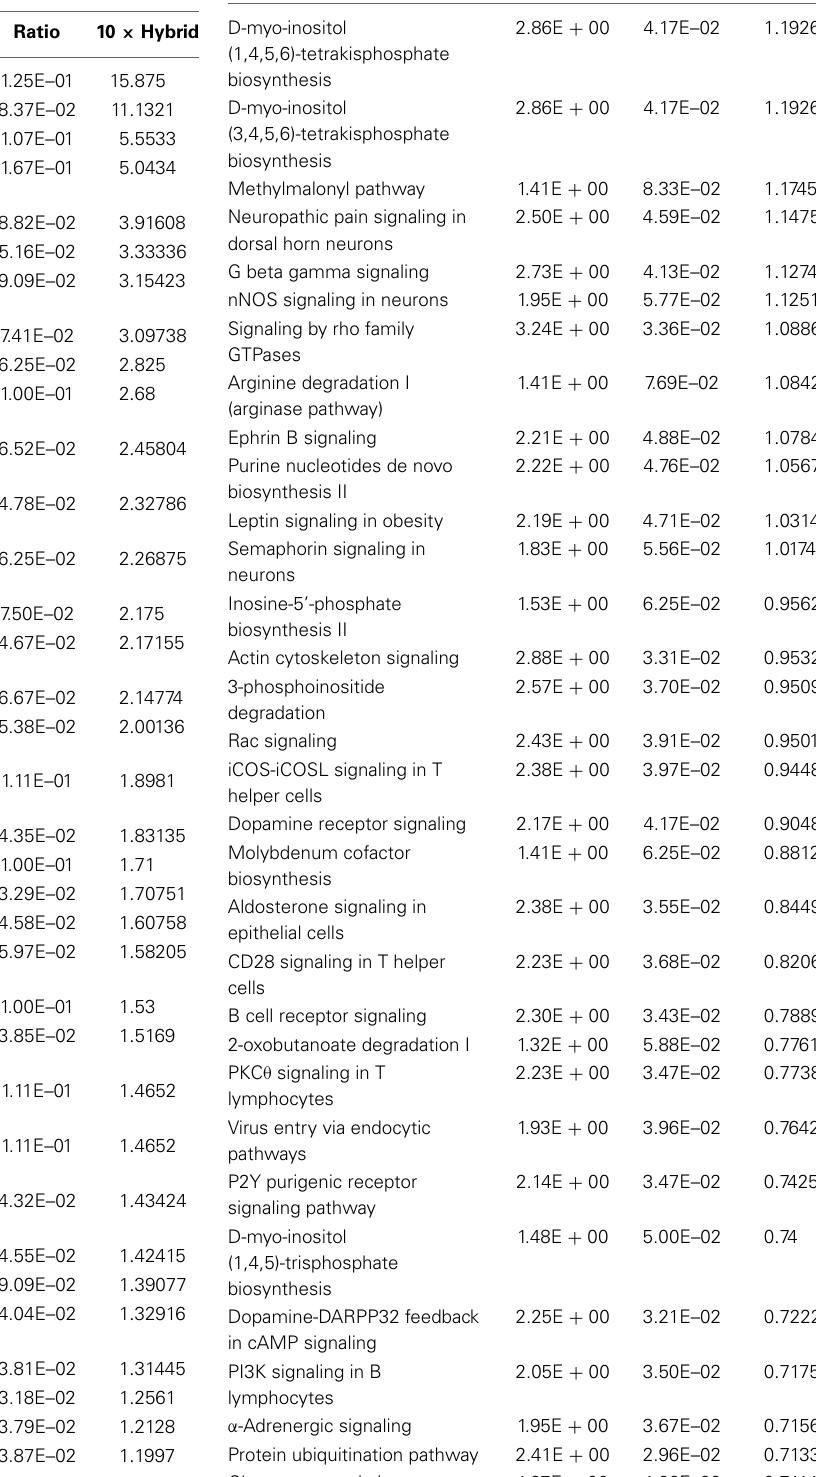
Table 6 | Ingenuity Canonical Signaling Pathway analysis of proteins differentially regulated in the hippocampus of aged BTBR compared to WT